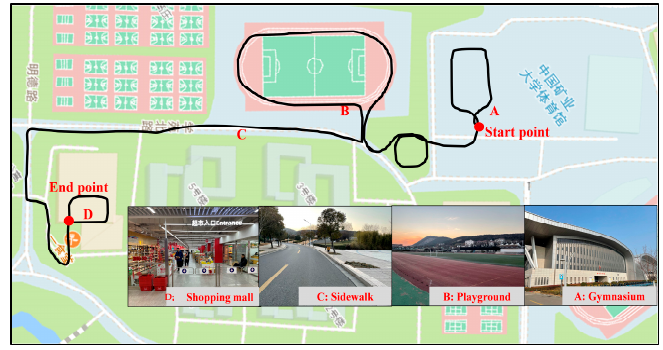
Figure 8. Pedestrian trajectory and test scenes description.